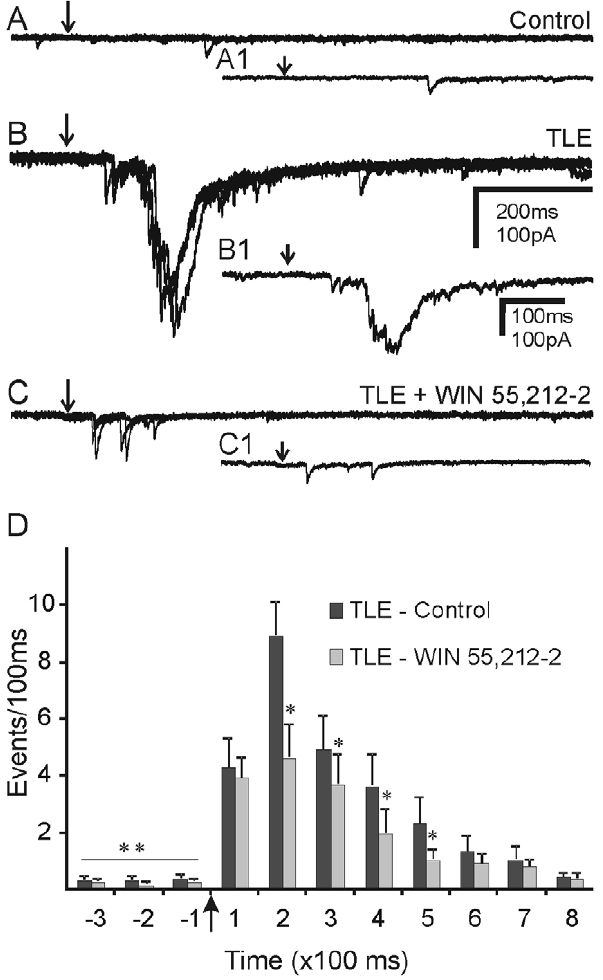
Figure 7. Cannabinoid-mediated attenuation of EPSC bursts evoked by glutamate ‘uncaging’ in the granule cell layer. Sets of 3 overlapping traces showing evoked EPSCs after photolytic release of caged glutamate (250 m M) at the same location in the granule cell layer of control mice and mice with TLE. Arrows indicate the time of uncaging. A . Uncaging glutamate in the granule cell layer did not evoke a synaptic response in control mice. B . EPSC bursts evoked in pilocarpine-treated mice that survived SE. C . In the same cell as B , EPSC bursts were attenuated by WIN 55,212-2 (10 m M). A1 , B1 and C1 show a single expanded trace from the group of traces shown in A , B and C . D . Grouped data from 6 cells showing the effect of WIN 55,212-2 on EPSC bursts evoked by photolysis of caged glutamate. Glutamate uncaging increased EPSC frequency over baseline; ** indicate significant difference in EPSC frequency before and after photolysis (p , 0.05). * indicate a significant reduction in EPSC frequency after application of WIN 55,212-2 during comparable post-photolysis 100 ms time periods (p , 0.05).